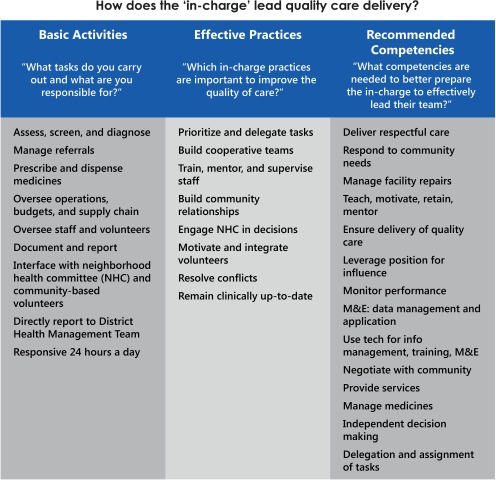
Tasks, Important Practices, and Recommended Competencies of Facility HeadsAbbreviations: M&E, monitoring and evaluation; NHC, neighborhood health committee.